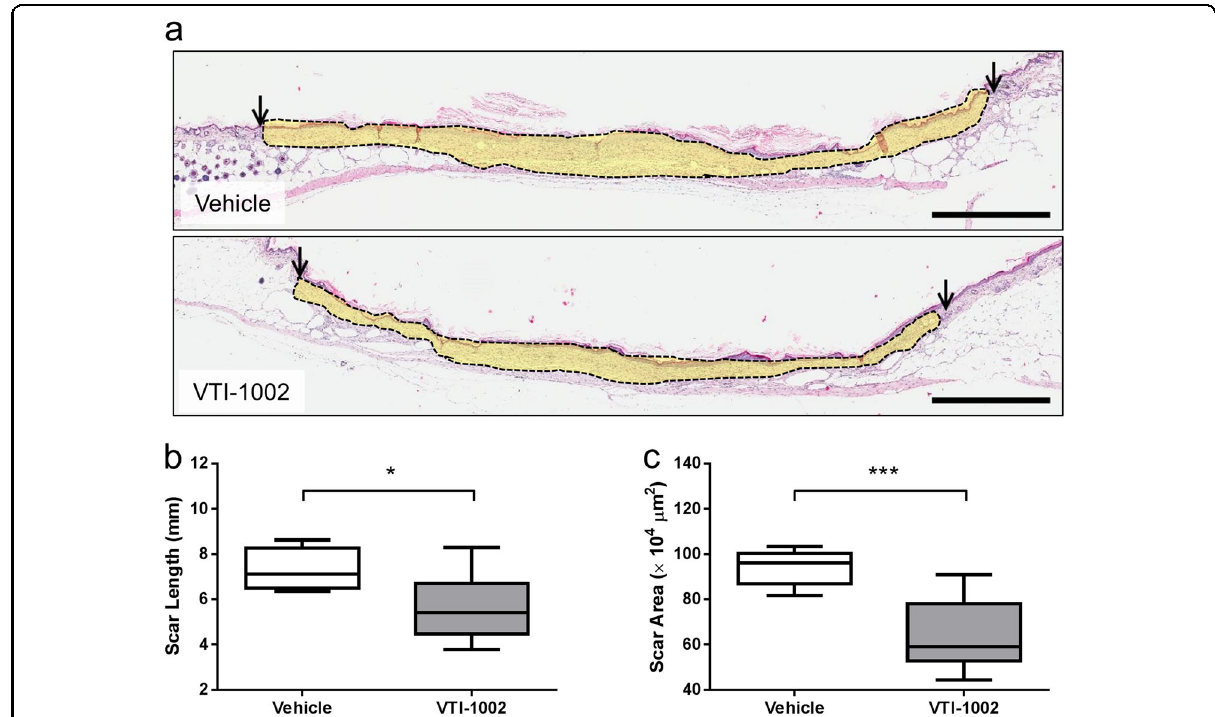
Fig. 3 Topical application of VTI-1002 gel reduces scar formation in diabetic burn wounds. a Representative histological images of skin sections from day 30 wounds treated with vehicle and VTI-1002 gel. Area outlined by black line and light yellow color represented scar tissue. Scale bar = 1 mm. b Comparison of scar length at day 30 between vehicle control group and VTI-1002 treatment group ( n ≥ 5 per group). c Comparison of scar area at day 30 between vehicle control group and VTI-1002 treatment group ( n ≥ 5 per group). Results are expressed as median and min/max value, * P < 0.05, *** P < 0.001 by Student's t